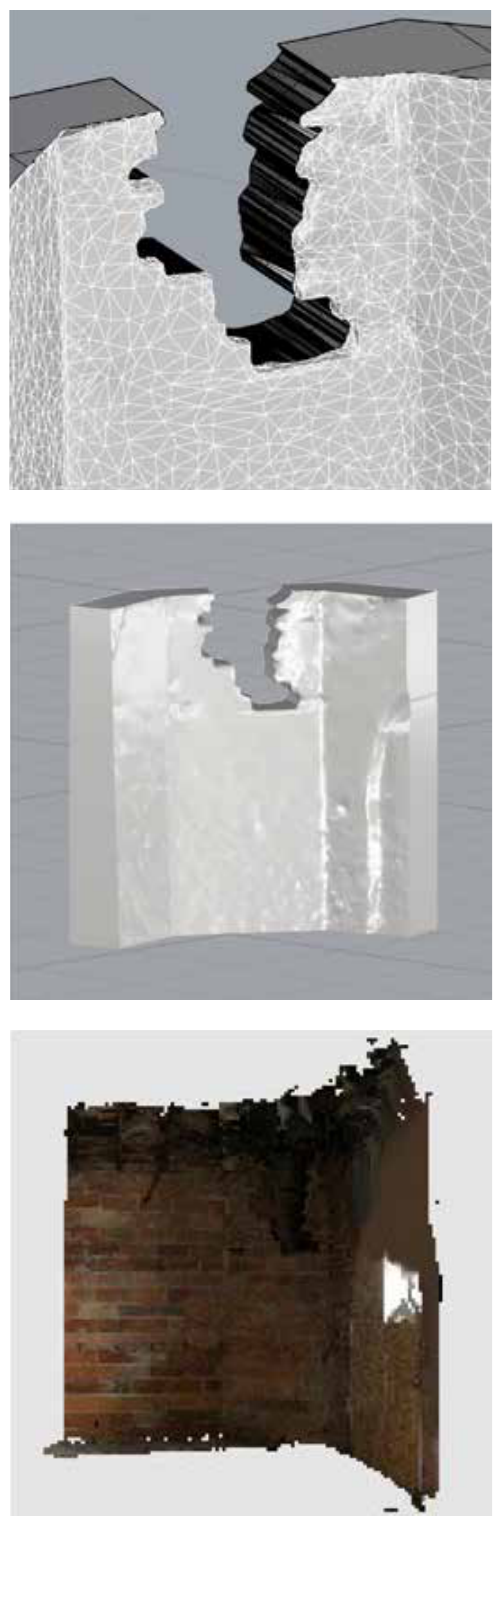
mistakes, the virtual robot turns red. The script